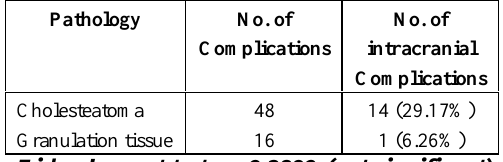
In patients with cholesteatoma the commonest extracranial complication was acute mastoiditis/ mastoid abscess/ fistula or Bezold's abscess 27 (79.41%). Three (8.82%) patients had multiple extracranial complications.Acute labyrinthitis/ labyrinthine fistula was present in 3(8.33%)